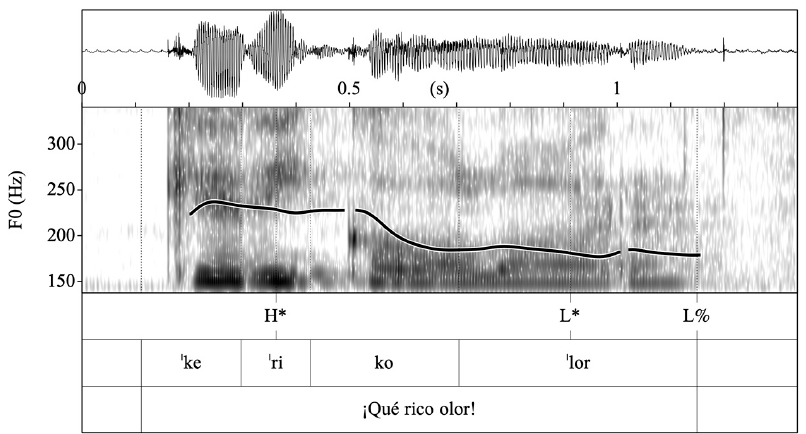
Figure 22. Waveform, spectrogram and F0 trace of the what -exclamative ¡Qué rico olor! in L2 Spanish (F20, level B1) produced with L* L%.